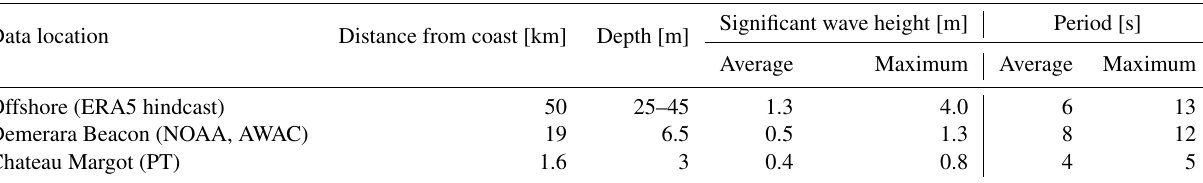
Figure 2. Overview of the alignment and bathymetric development of the transect from 1970–2020. (a) The northeastern alignment of the transect (MB) with the instrument locations shown at the red dots. (b) The evolution of the bed level spanning the mudbank cycle: pre- mudbank presence, with the mudbank, pre-restoration and almost 10 years post-restoration. Characteristic tidal water levels are indicated at the right axis (HWS: high-water spring; HWN: high-water neap; LWN: low-water neap; LWS: low-water spring; MSL: mean sea level). Table 1. Historical wave data (between the years 1969–1971) presented at locations along the coastal area of Guyana (NEDECO, 1972; Van Duivendijk et al., 1982). PT: pressure